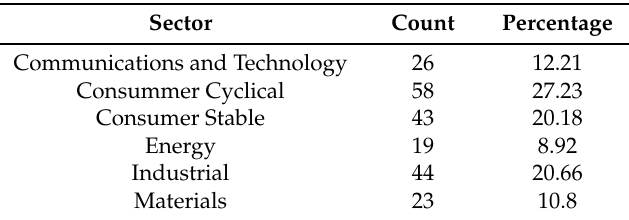
Table 2. Industrial